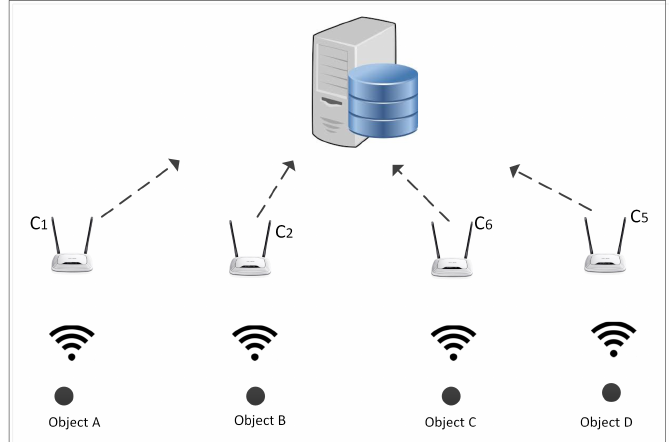
Figure 3. Indoor WiFi-based positioning